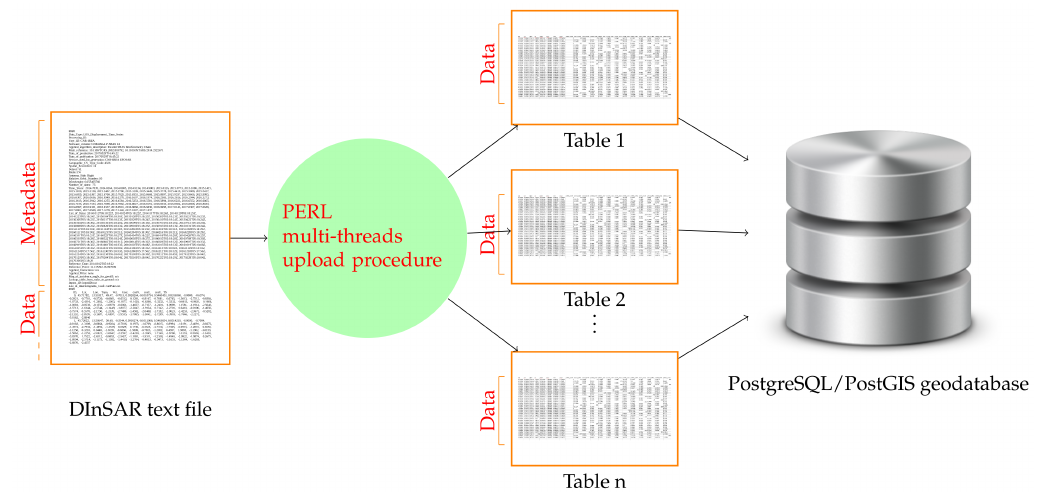
Figure 6. Flow chart of the uploading information procedure.